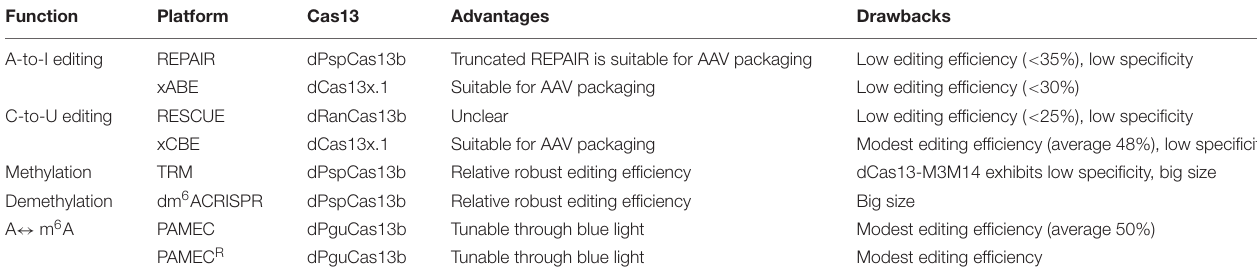
TABLE 2 | The advantages and drawbacks of epigenetic editing